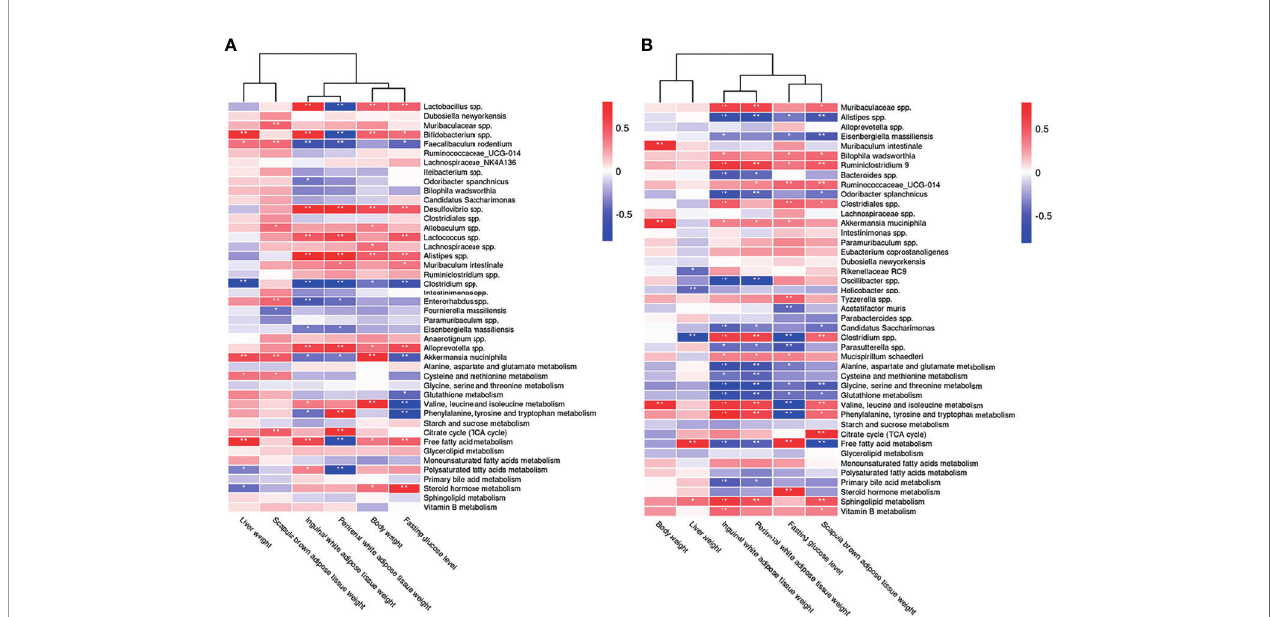
FIGURE 10 | Correlations between the host metabolome, fecal microbiome and hepatic- and adipose- phenotype. (A) Spearman correlations of the relative abundance of fecal microbial genus or species, the abundance of metabolite pathways and phenotype of obesity and fasting glucose in host serum of 4 CIH-related modeling groups (n = 36). (B) Spearman correlations of the relative abundance of fecal microbial genus or species, the abundance of metabolite pathways and phenotype of obesity and fasting glucose in host serum of 4 PSD-related modeling groups (n = 36). The r values are represented by gradient colors, with red cells indicating positive correlations and blue cells indicating negative correlations. *P < 0.05, and **P <